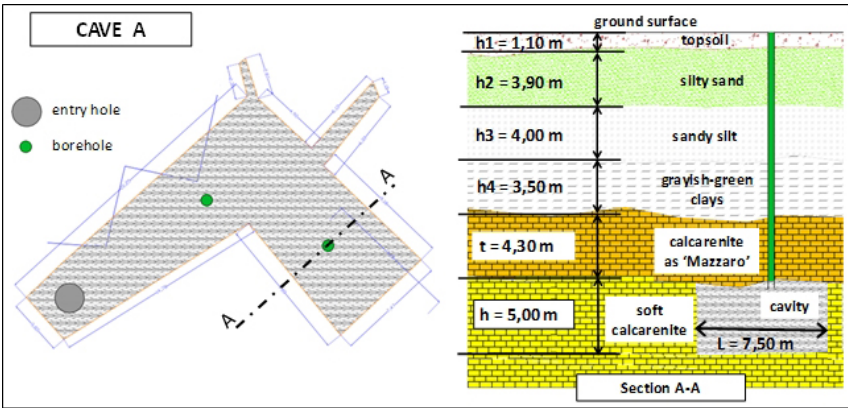
Figure 20. Plan and stratigraphy of the underground cavity A (adapted from Maglio and Ligori, 2014).